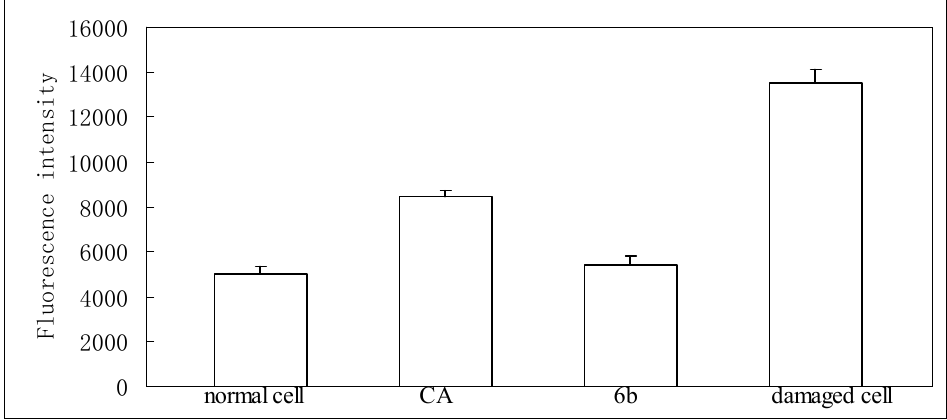
Figure 2. Inhibitory effect of chlorogenic acid (CA) and its amide analogue ( 6b) on reactive species of oxygen (ROS) formation.